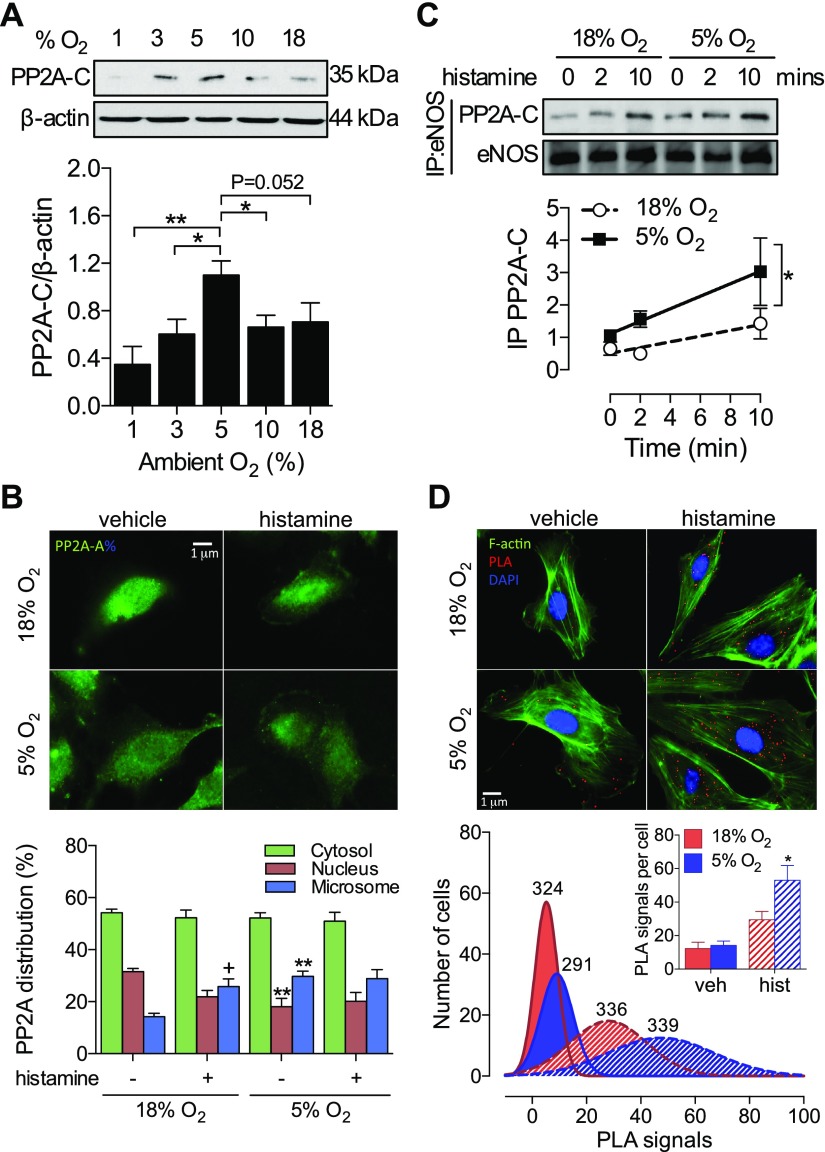
PP2A is responsible for histamine-stimulated eNOS dephosphorylation. HUVECs were maintained at 18% O2 or cultured in 10, 5, 3, or 1% O2 for at least 5 d. A) Representative immunoblot and densitometric analysis of PP2A-C expression relative to β-actin. B) Analysis of PP2A subcellular distribution in response to histamine stimulation (10 µM, 5 min) using immunofluorescence and ultracentrifugation (Supplemental Fig. S4). DAPI costaining not shown for clarity. C, D) Colocalization of eNOS and PP2A-C assessed by coimmunoprecipitation (C) and proximity ligation assay (D). Red dots indicate physical protein interaction. The total number of cells is indicated above each frequency distribution; data are means ± sem. PLA signals per cell shown in the inset. All other data represent means ± sem from 3 to 9 different donors. *P < 0.05, **P < 0.01 vs. 18% O2; +P < 0.05 vs. vehicle.